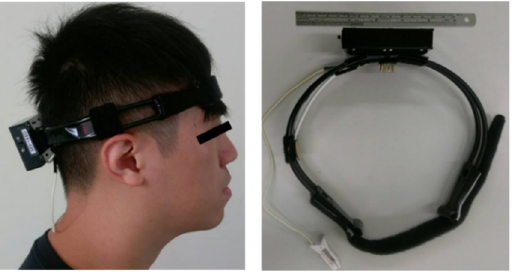
Figure 3. Photograph of wearable mechanical design in the proposed system.